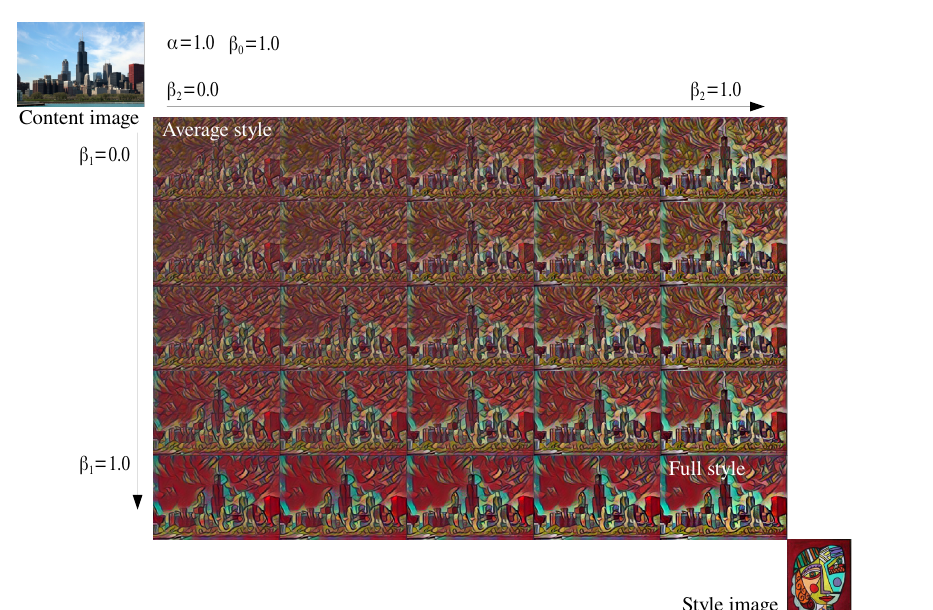
Figure 7. Examples of component-wise style